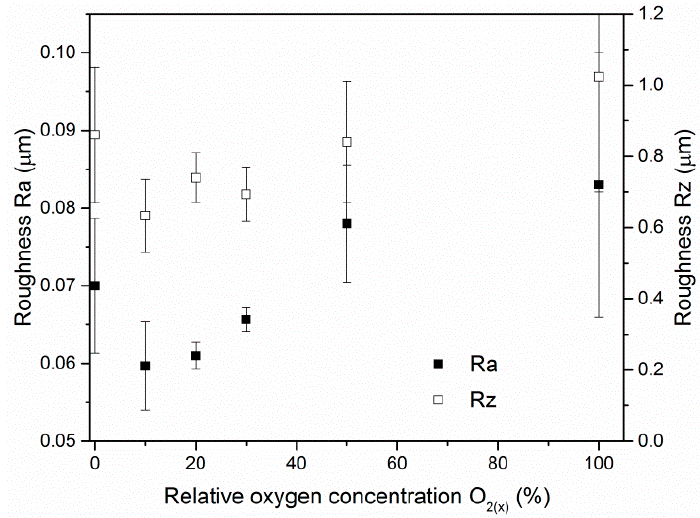
Figure 5. Ra and Rz roughness parameters of ZrON coatings formed at different relative oxygen concentration O 2(x) .